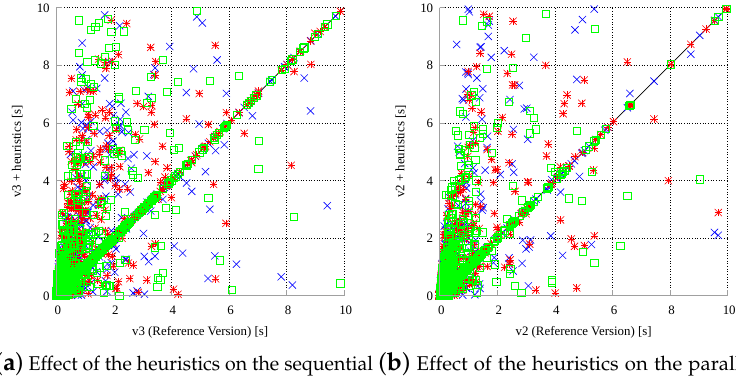
Figure 8. Running times for different heuristics (reported on the y-axis) implemented within the sequential ( a ) and parallel ( b ) version, and reported on the